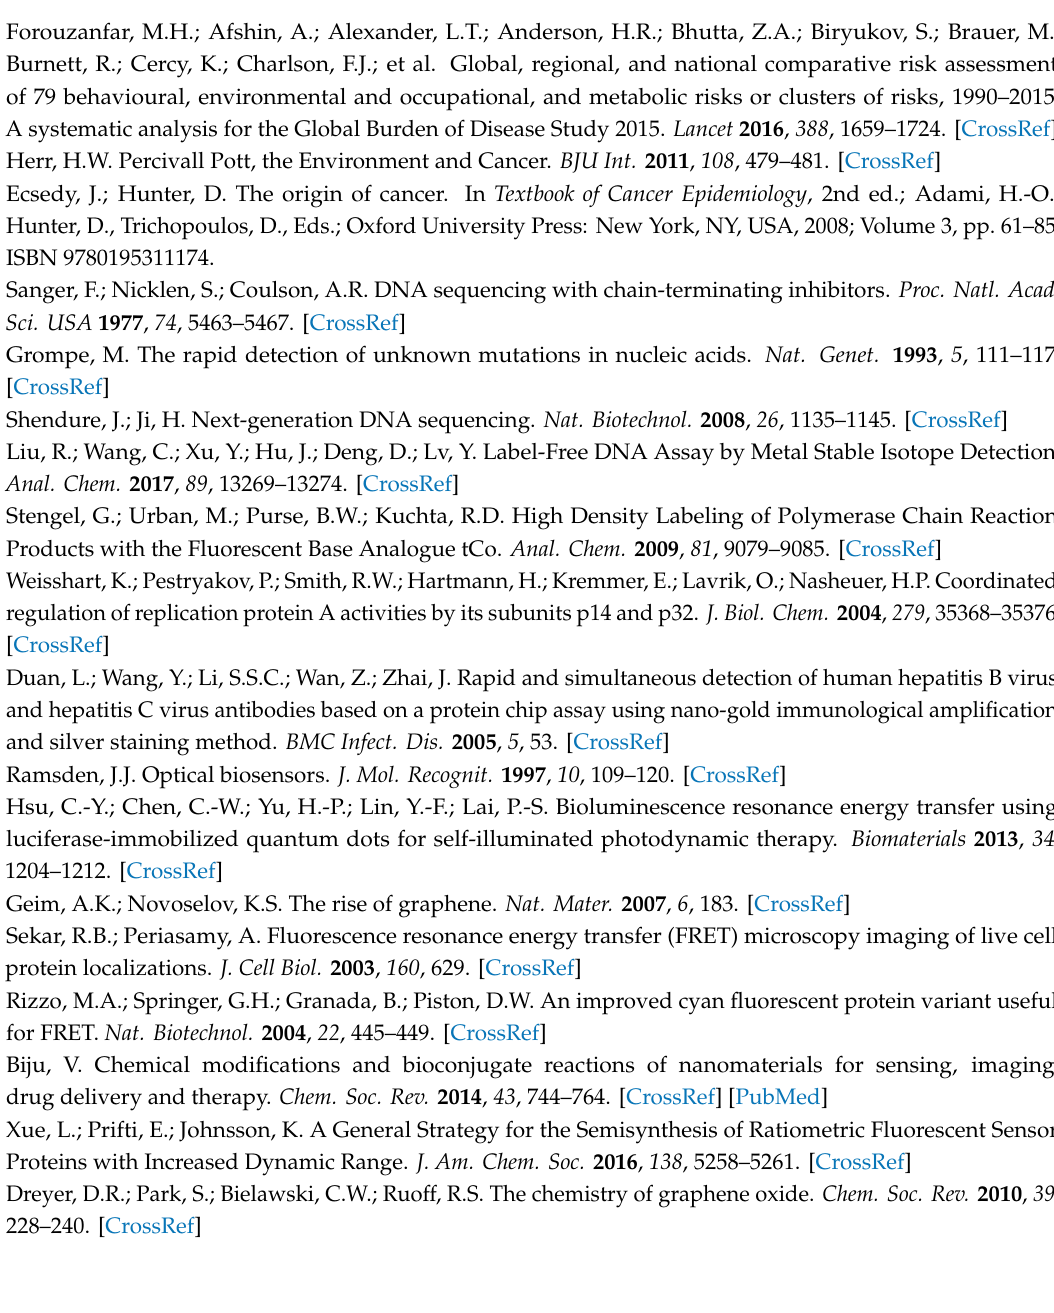
Figure S1: UV absorbance of DNA with di ff erent concentrations in aqueous